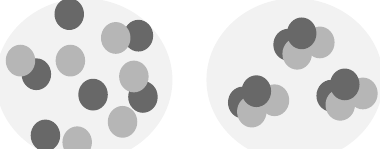
Figure 8.1: The light elements in the N,Z plane. Sta- ble nuclei are painted brown. Unstable elements with long lifetime are painted yellow. Unstable nuclei with very short lifetime are painted red. The A=Z+N=5 and A=Z+N=8 nuclear barriers are shown as straight lines. The nuclear forces do not yield a stable nucleus for these combinations of protons and neutrons. There is only one nucleus with A=4 stable or unstable. Al- Figure 2: The nuclear barriers at A=5 and A=8,